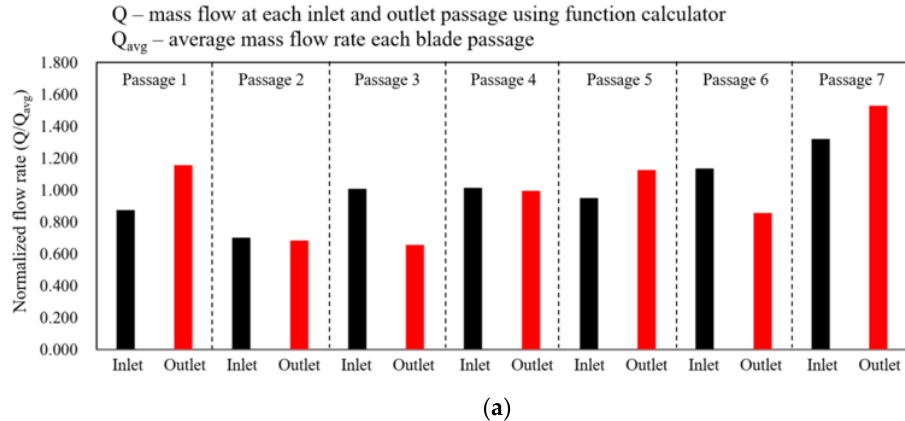
Figure 19. Comparison of the blade-loading distribution under the runaway condition: ( a ) Full-